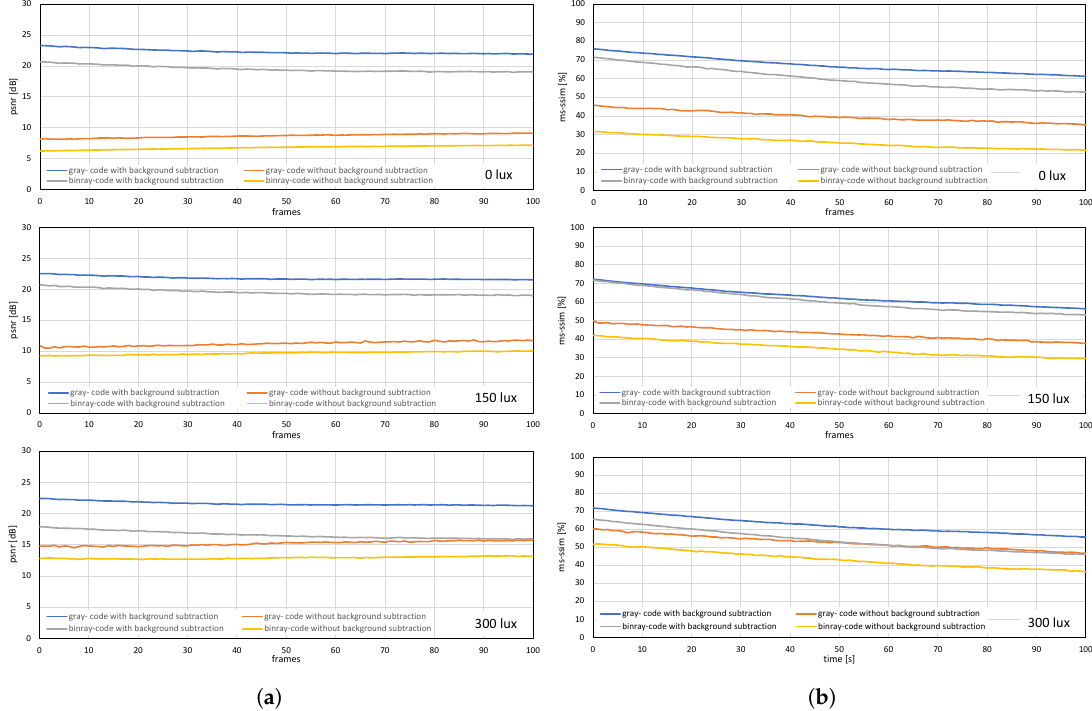
Figure 13. ( a ) PSNRs and ( b ) MS-SSIMs when a stored video sequence is streamed with pure-binary-code and gray-code images on a patterned